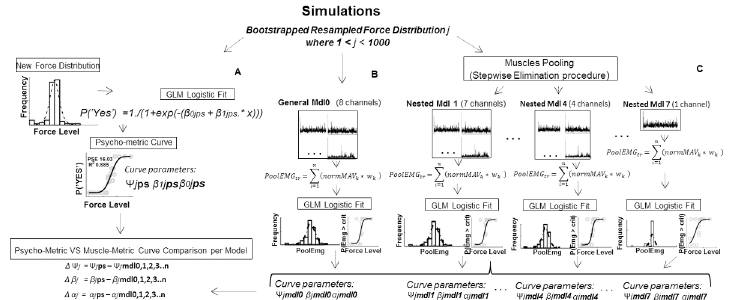
Fig 3. Bootstrap and Stepwise Elimination Procedures. A) For each of the 1000 simulated experiment (resampled stimulus force order) psychometric curve was obtained by fitting a logistic function to the probability of a positive answer with respect to each external force level (x). Ψ ps , β 1ps , β 0ps indicate the absolute threshold (PSE), the slope and the intercept, respectively, characterizing the logistic function that best explains the probability of detecting an upward force given each stimulus force. B) Computation of 1000 muscle-metric curves (one per each new force presentation order) obtained by means of a weighted pool of all 8 muscles activity (PoolEMG). C) Computation of 1000 muscle-metric curves (one per each new force presentation order) obtained from each nested model of the muscles activity pooled as above (PoolEMG), whose number of terms was iteratively reduced from 7 to 1. Once 1000 simulated experiments were performed per each nested model, muscle-metric and psycho-metric curves output were compared (bottom